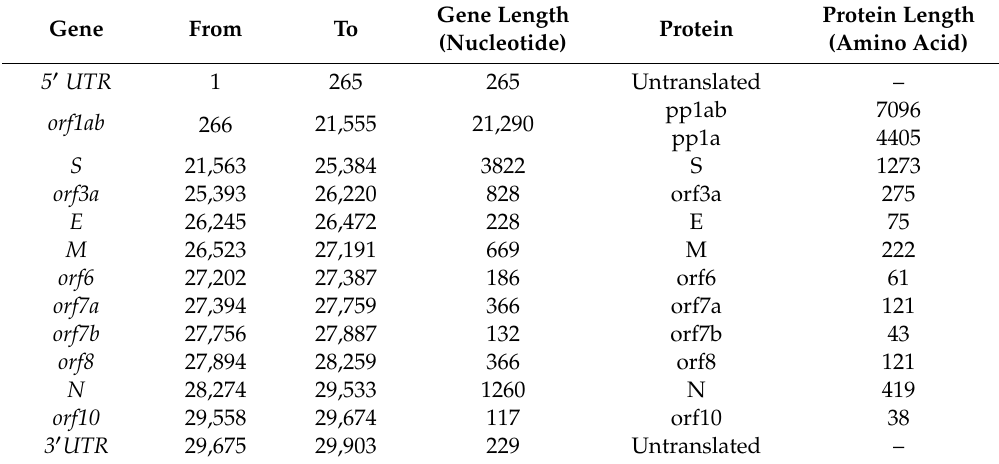
Table 3. SARS CoV-2 genes and encoded